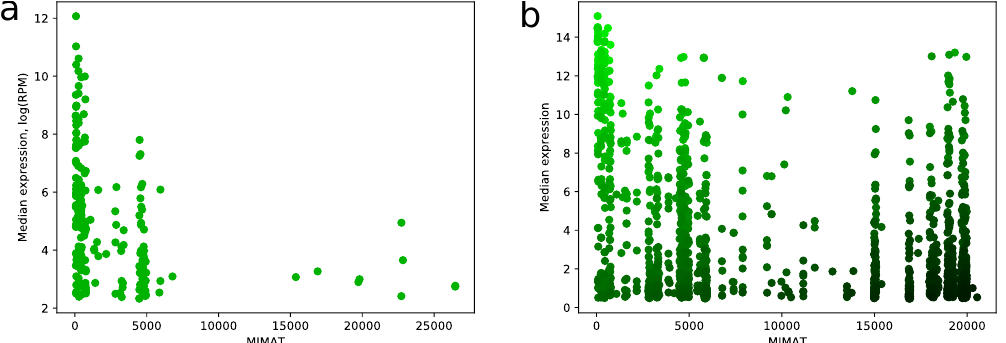
Figure 6. MIMAT number vs expression level. ( a ) scatter plot showing relation between MIMAT number and log -transformed median expression value for all miRNAs from TCGA miRNA-seq data 2 with RPM value greater than 10; ( b ) the same plot for all miRNAs from microarray data. Color of point indicates score value: green points correspond to high scores and black points correspond to low